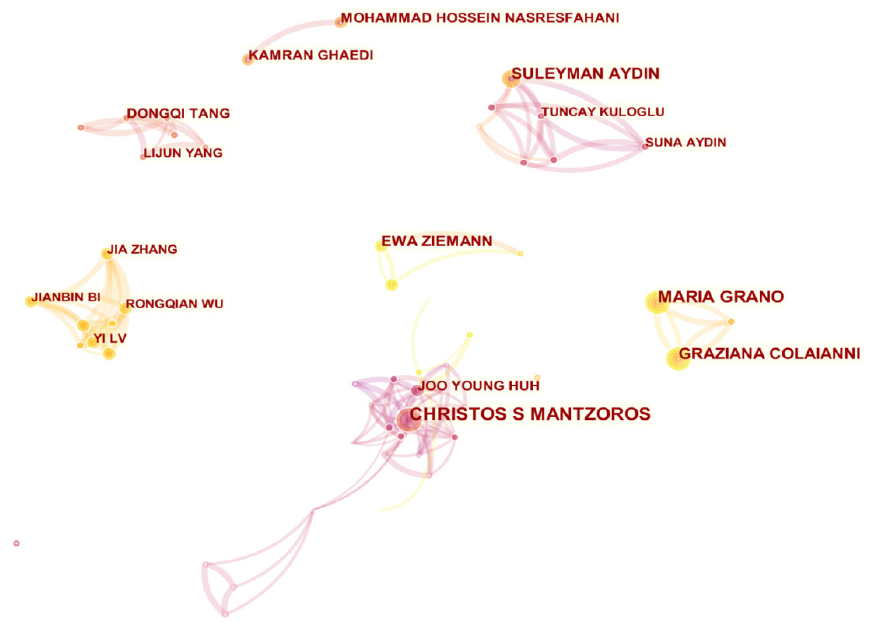
Figure 5. The co-occurrence knowledge map of irisin research authors.